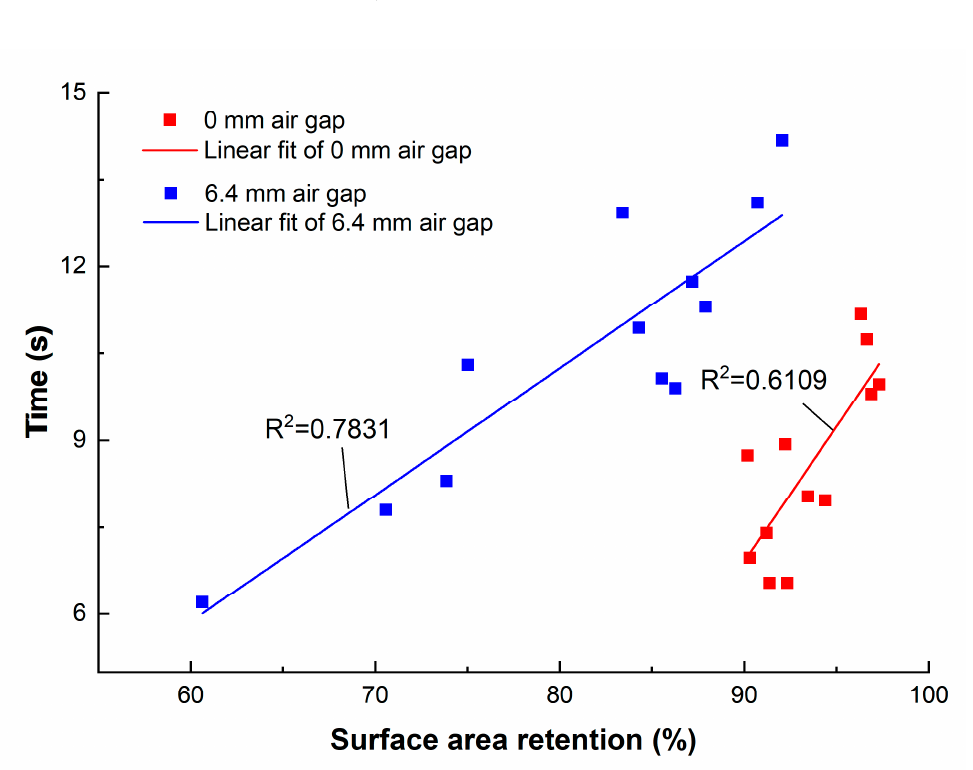
Figure 10. Relationship between the surface area retention and thermal protective performance under 0-mm- and 6.4-mm-air-gap conditions of Nomex IIIA specimens.